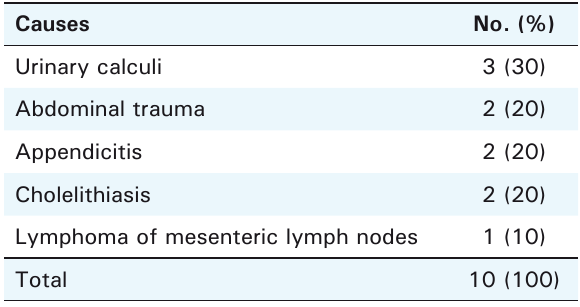
table 5. Surgical causes of pain abdomen